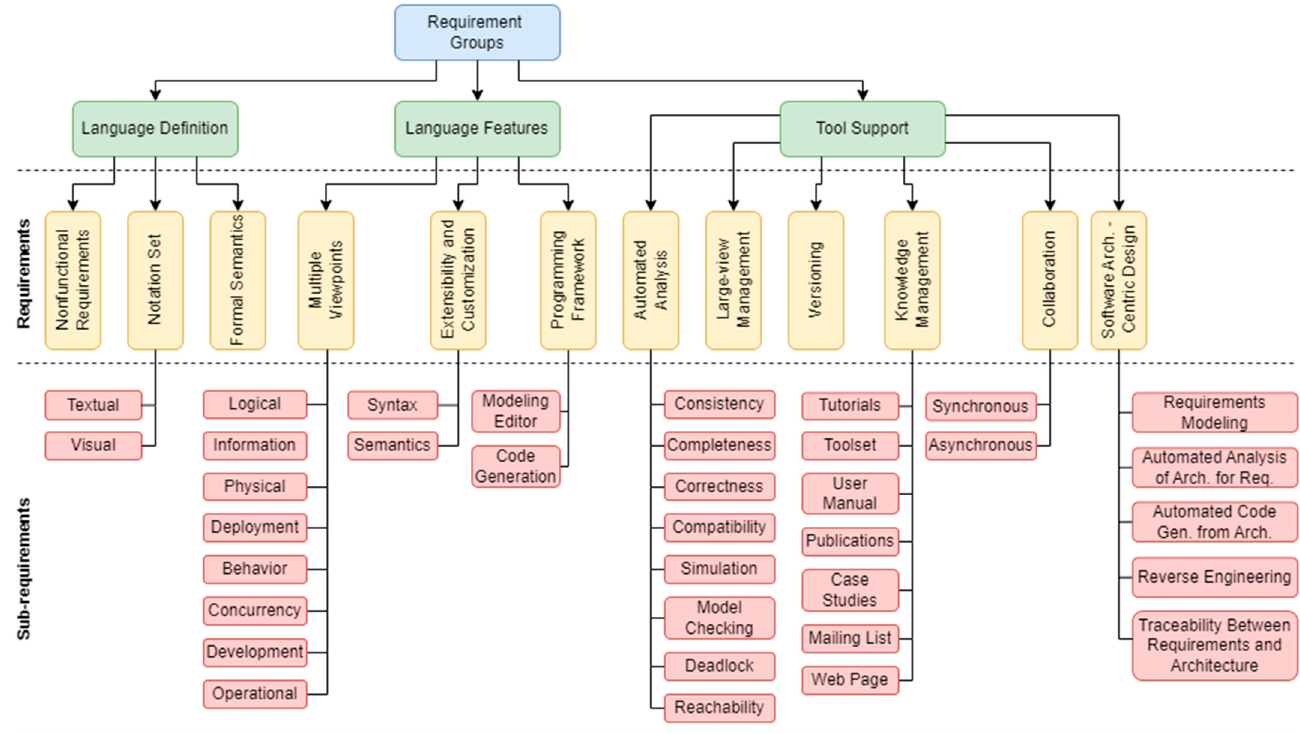
Figure 2. The requirements classification diagram that we used for analyzing the modeling languages for IoT.